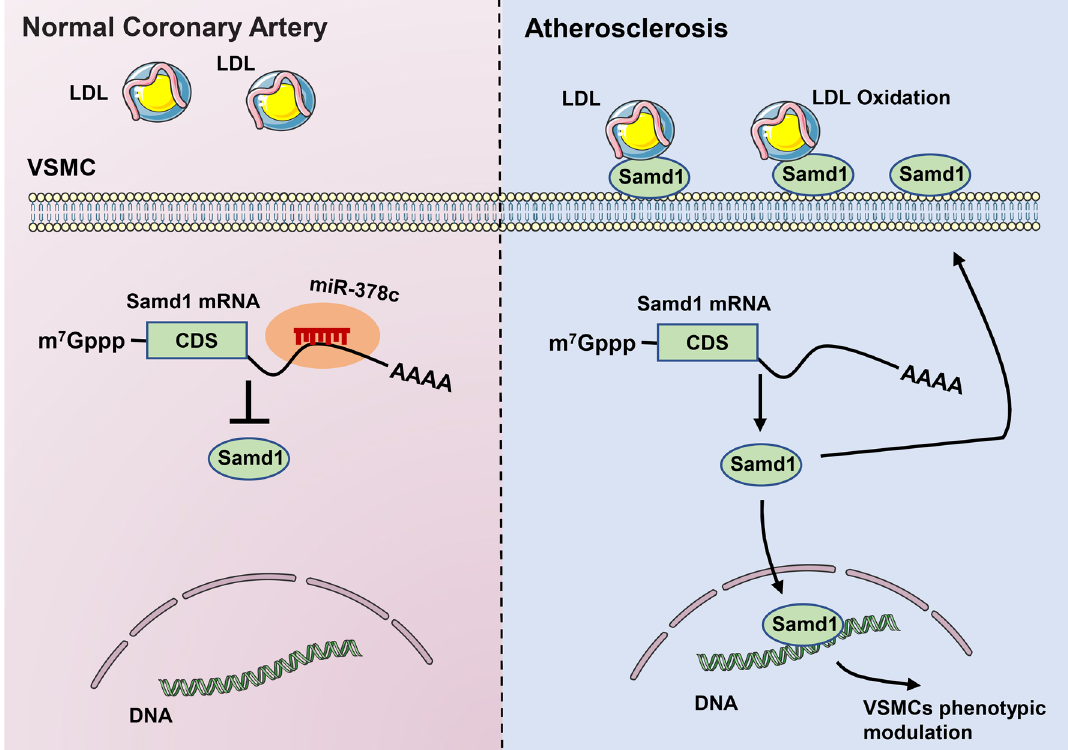
Figure 7. Working model: The miR-378c-Samd1 circuit promotes phenotypic modulation of vascular smooth muscle cells and foam cells formation in atherosclerosis